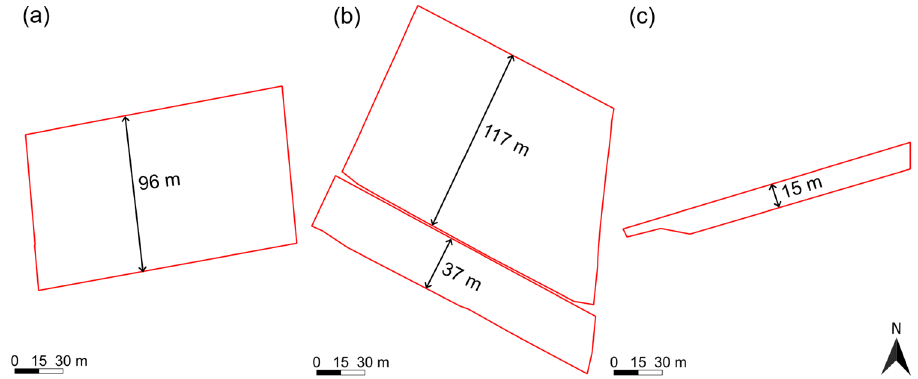
Figure 3. Example of parcels that could be analysed ( a ) on their own and ( b ) after FOI merging and ( c ) were too small for analysis.